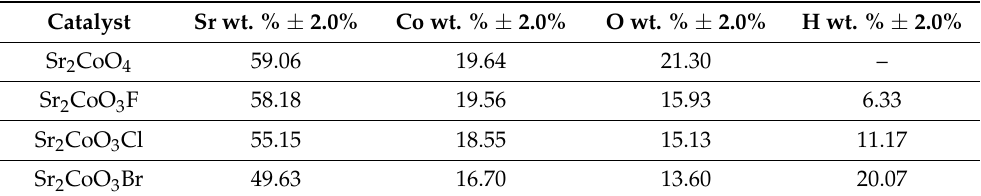
Figure 3. SEM-EDX composition map analysis of Sr 2 CoO 3 F catalyst. Table 1 SEM-EDX elemental composition analysis of the strontium cobalt oxyhalide catalysts in comparison to the parent oxide of Sr 2 CoO 4 . Table 1. The EDX elemental composition analysis of the strontium cobalt oxyhalide catalysts and the parent oxide of Sr 2 CoO 4